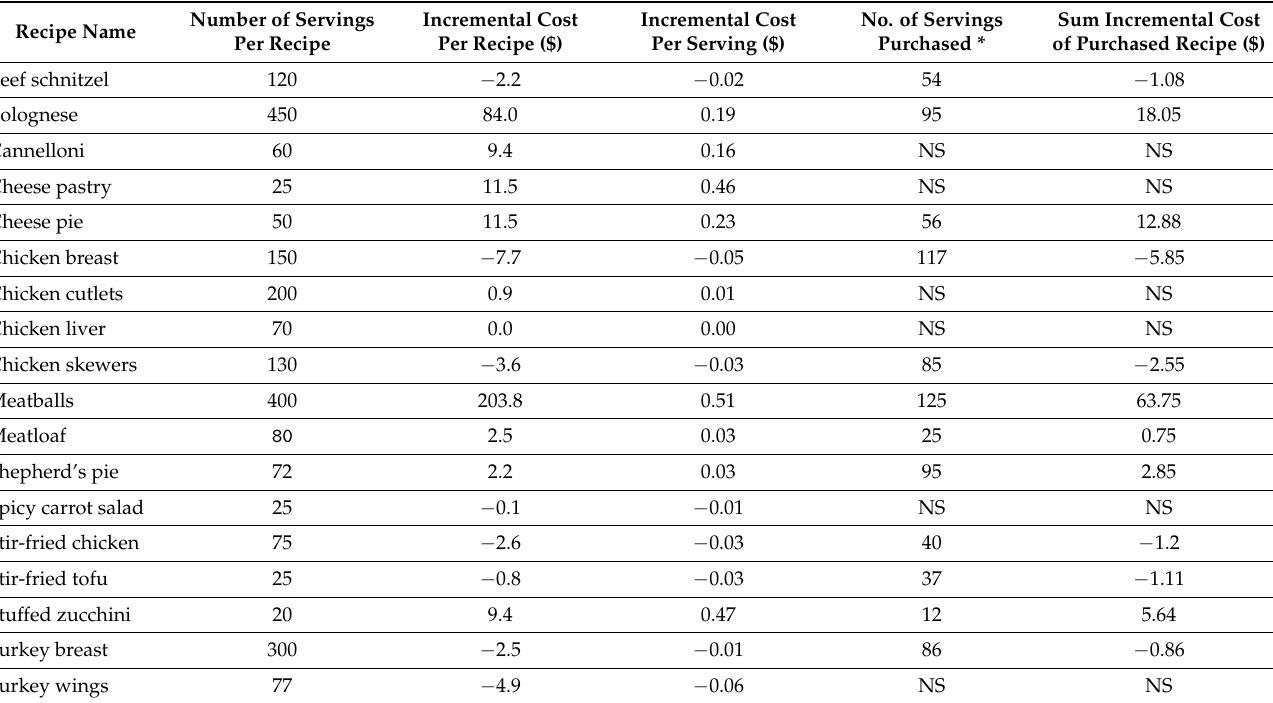
Table 2. Incremental costs (USD) associated with recipe ingredients